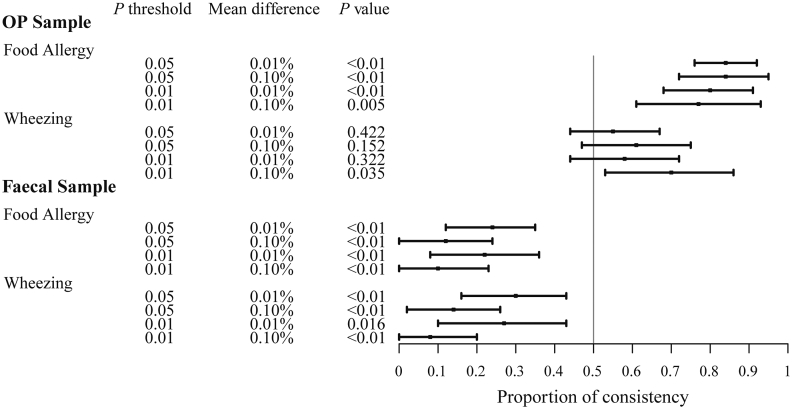
– Consistency in trends of taxa abundance between the oropharyngeal (OP) and fecal microbiome: Left columns indicate the taxa selection thresholds p values (0.05 and 0.01) for the abundance comparison between AC and CC children, and the mean difference between with or without allergic conditions (over 0.01% or 0.10%). The “P value” column represents the significance of each binomial probability test. The horizontal axis of the plot represents the proportion of consistency of taxa abundance that is higher or lower in AC children (compared to CC children) and in children with allergic conditions (relative to children without allergies) among AC children. At the vertical “line of null effect” there is no consistent trend. Each horizontal line on the plot represents a consistent trend under certain thresholds. The black box indicates the mean value of the proportion of consistency, and the horizontal line represents the 95% confidence intervals.